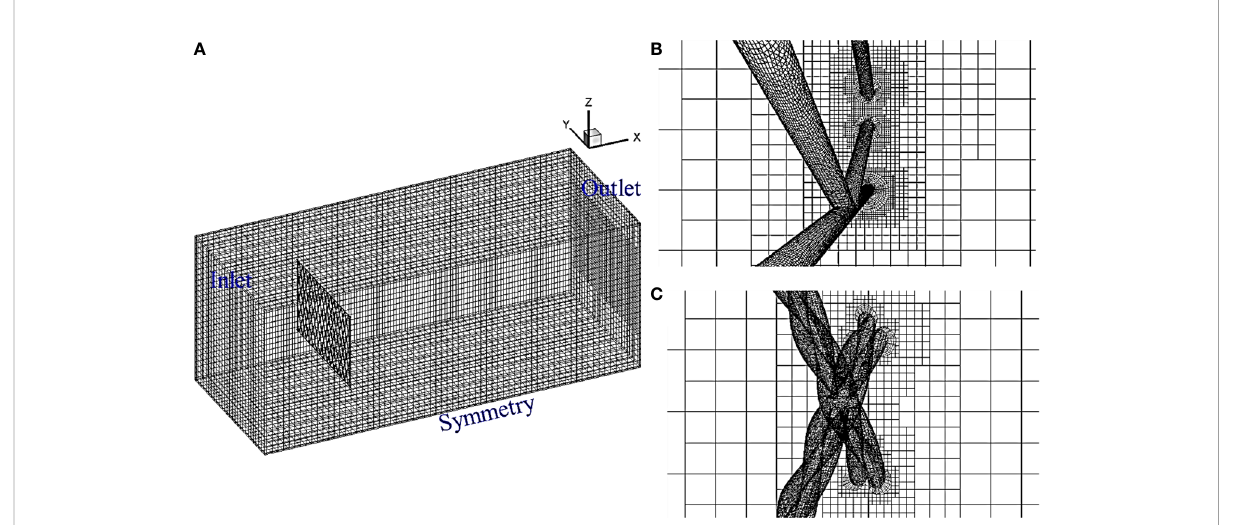
FIGURE 3 The schematics of the computational domain and the hexahedral grids. (A) The overall computational domain, (B) and (C) zoom-in views and prism layers around the net